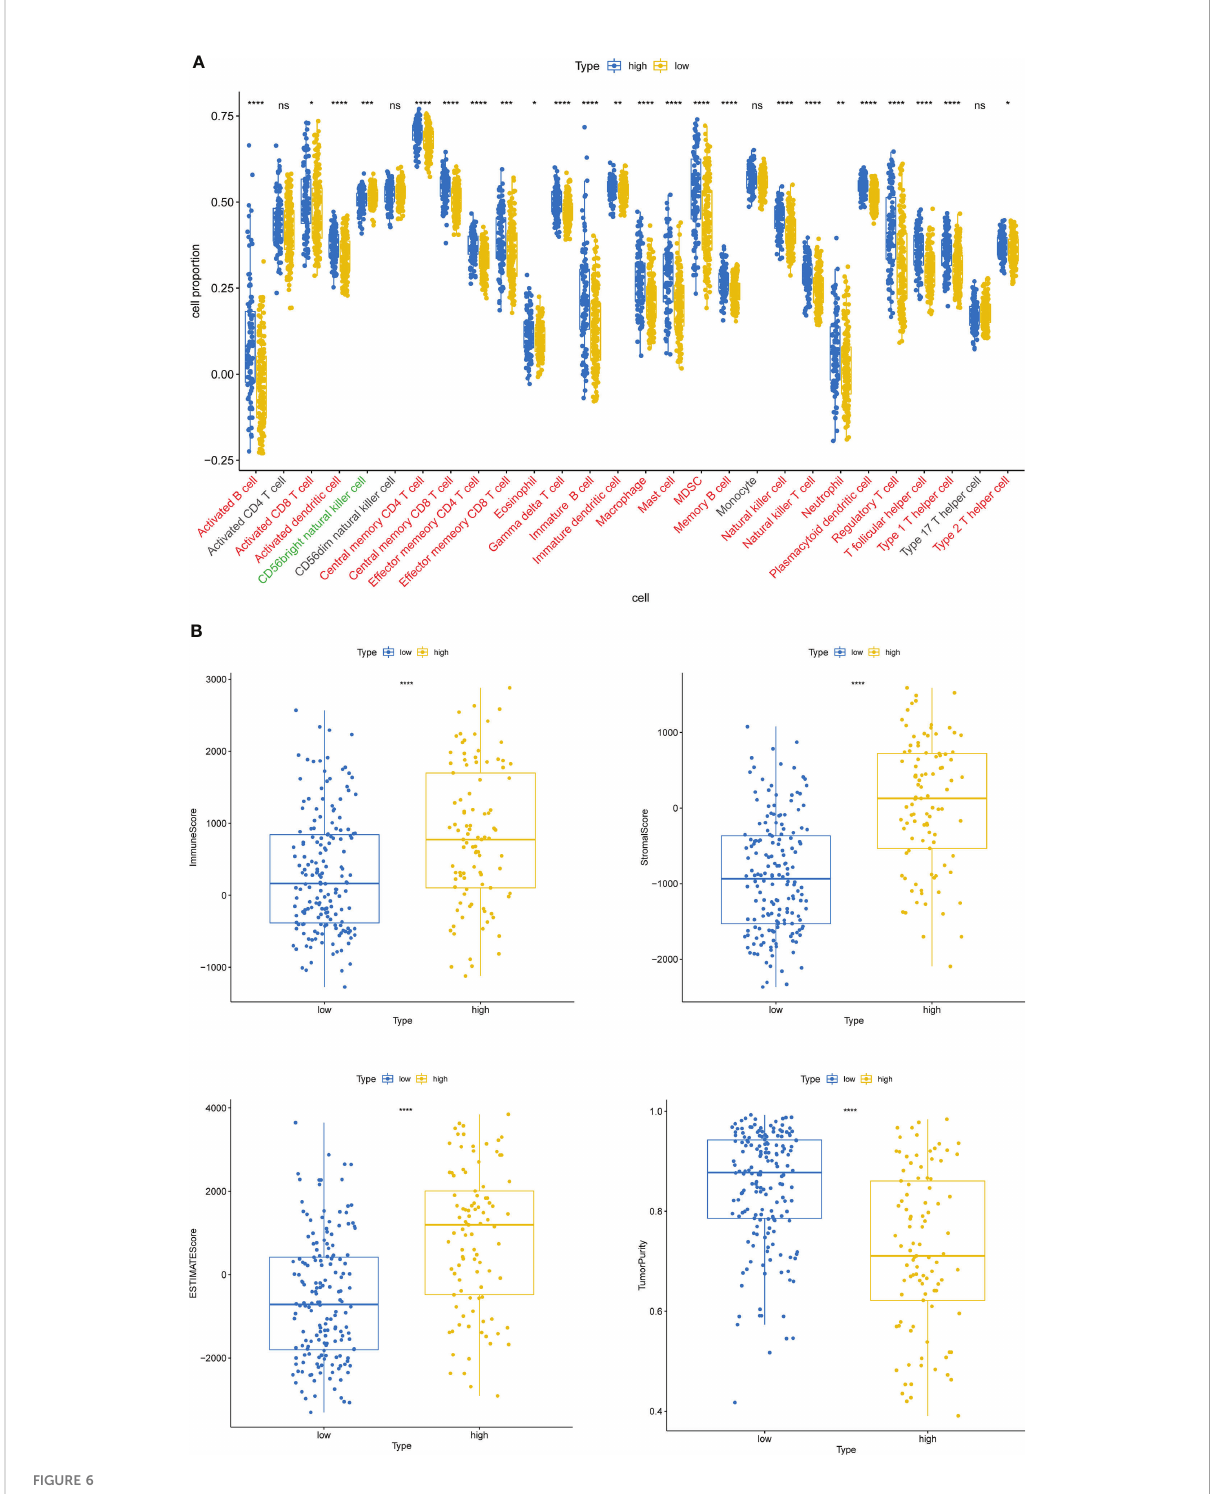
FIGURE 6 Immune cell in fi ltration characteristics of high- and low-risk groups. (A) The content of 28 immune cells in diverse risk subclasses assessed by the ssGSEA algorithm. ns, non-signi fi cant. (B) The immune score, stromal score, ESTIMATE score, and tumor purity in diverse risk subgroups assessed by the ESTIMATE algorithm. *P < 0.05, **P < 0.01, ***P < 0.001,****P <